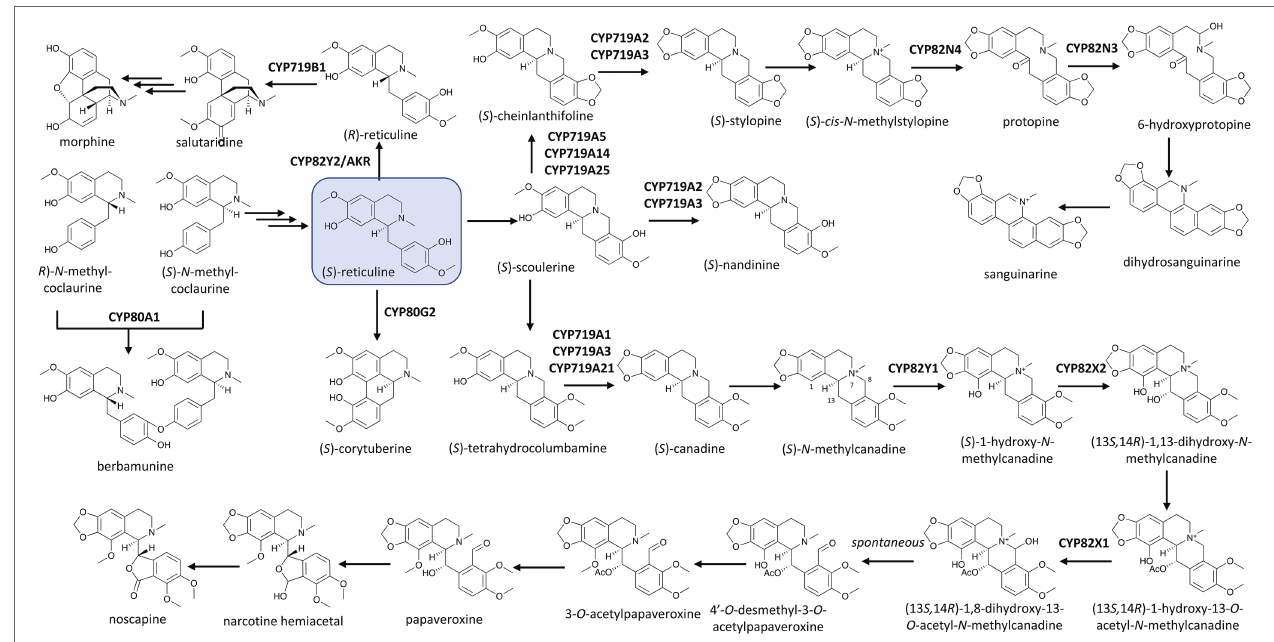
FIGURE 1 | P450s in the biosynthetic network of benzylisoquinoline alkaloids (BIAs) in the Ranunculales with ( S )-reticuline (boxed) as the central precursor. Multiple and single arrows indicate multiple- and single-step pathways, respectively. Enzymes indicated here are discussed in the